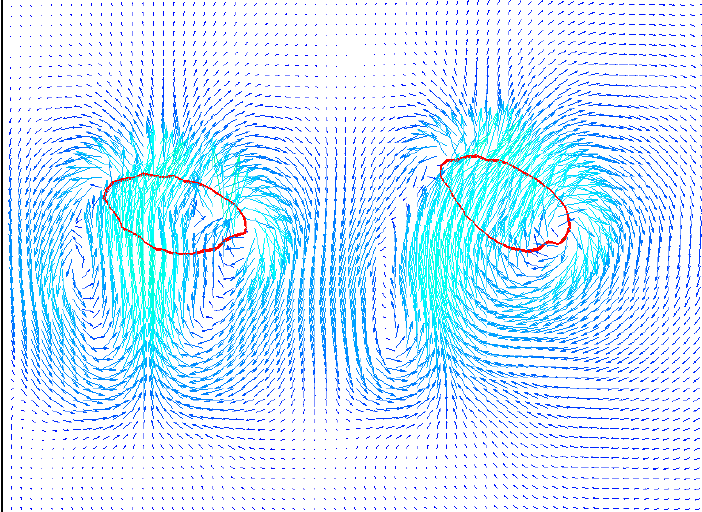
Figure 19. The upward flow field of double bubbles arranged horizontally near the wall at 90 ms. (3) Double bubbles arranged horizontally at 4 times diameter spacing Error! Reference source not found. shows the rising deformation of horizontally ar ‐ ranged double bubbles with a bubble spacing of four times the diameter. It can be seen from the figure that at four times the diameter, the interaction between the bubbles be ‐ comes very insignificant, the right bubble basically rises in a straight line, and the rising speed of the right bubble is significantly faster than the left bubble at 850 ms. It can be confirmed that when the distance between the bubble wall and the bubble wall gradually increases, the influence of the wall surface on the bubble will gradually weaken, and the rising speed of the bubble will gradually increase.